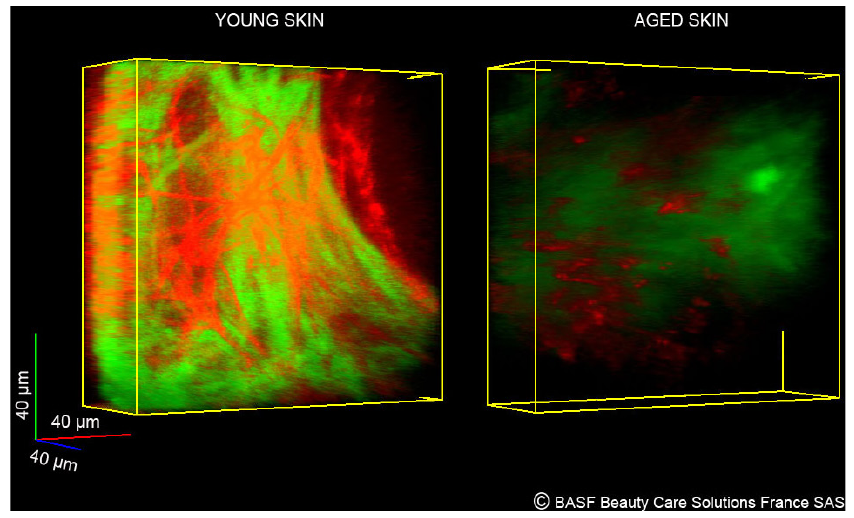
Figure 6. In vivo optical biopsy illustrating collagen and elastin levels. Collagen (SHG-signal in green) and elastin (autofluorescence in red) distribution in function of age. The serial images from Multiphoton microscopy were reconstructed and visualized with platform SkinExplorer™. R = −0.246; p <